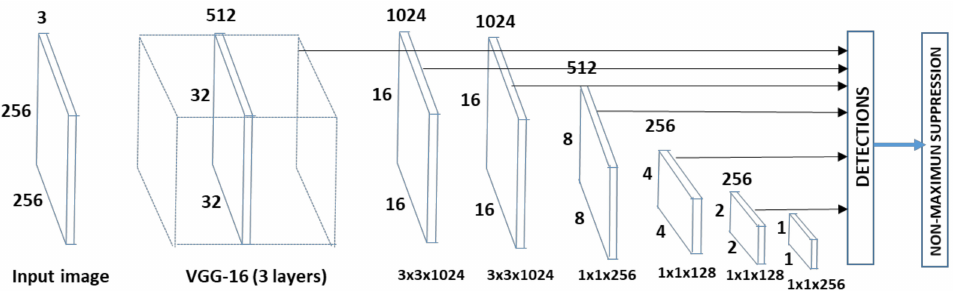
Figure 7. The Single-Shot Multibox Detector (SSD) network used for event type classification